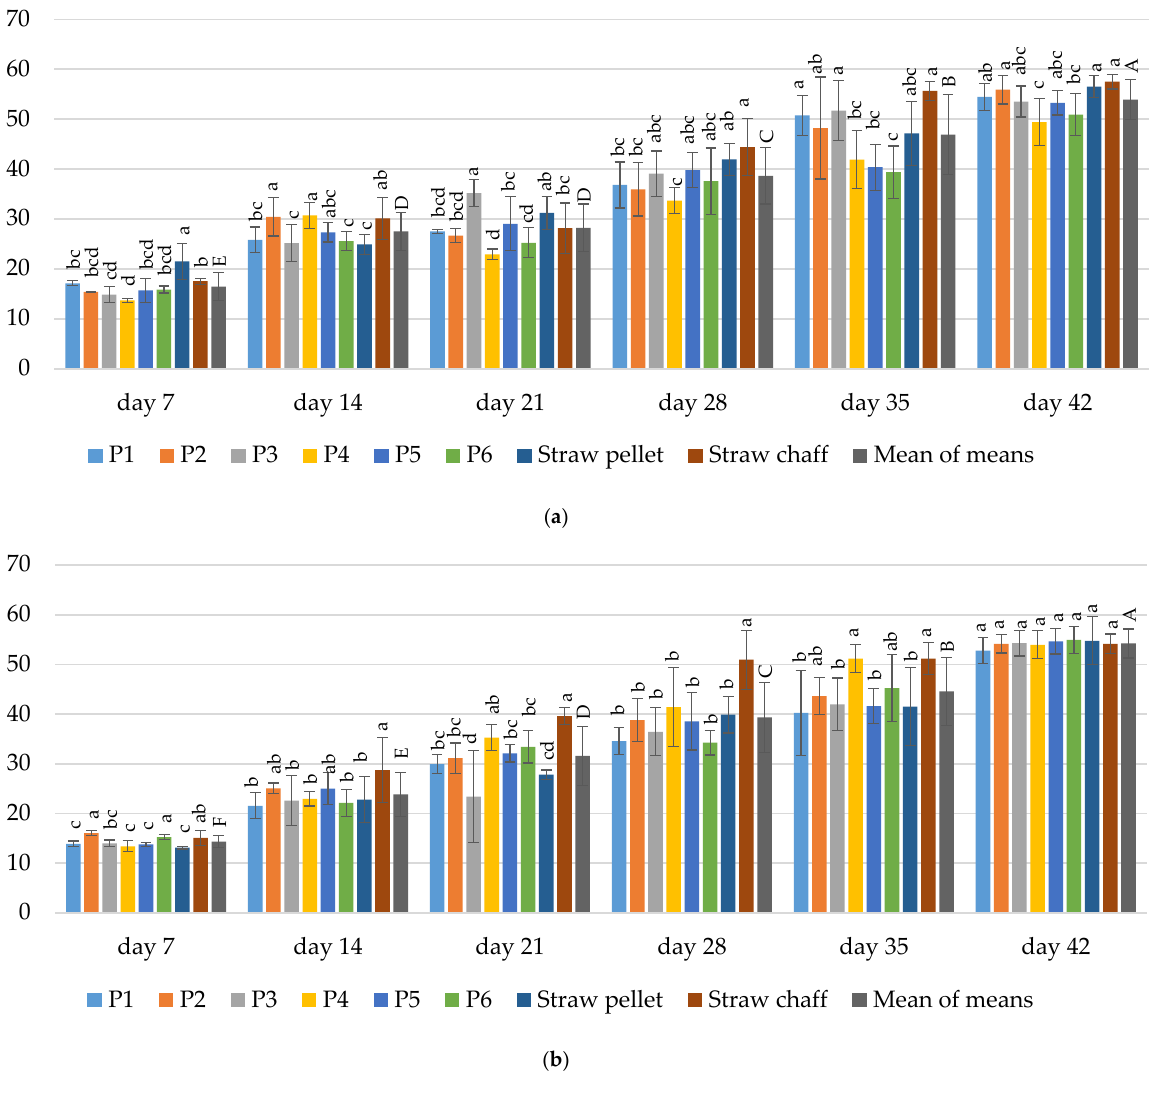
Figure 3. Changes in the moisture content in the tested bedding materials during: ( a ) 1st experimental cycle; ( b ) 2nd experimental cycle. All values are means of three independent replicates ± SD, except the last bars for each day, which are the means-of-means. For each day, means with a common lowercase letter are not significantly different by the Tukey test at the 5% level of significance. For different days, means-of-means with a common uppercase letter are not significantly different by the Tukey test at the 5% level of significance. Pairwise comparisons between materials are presented only for observations from the same day. Pairwise comparisons between days are presented only for means-of-means. No pairwise comparisons between cycles are